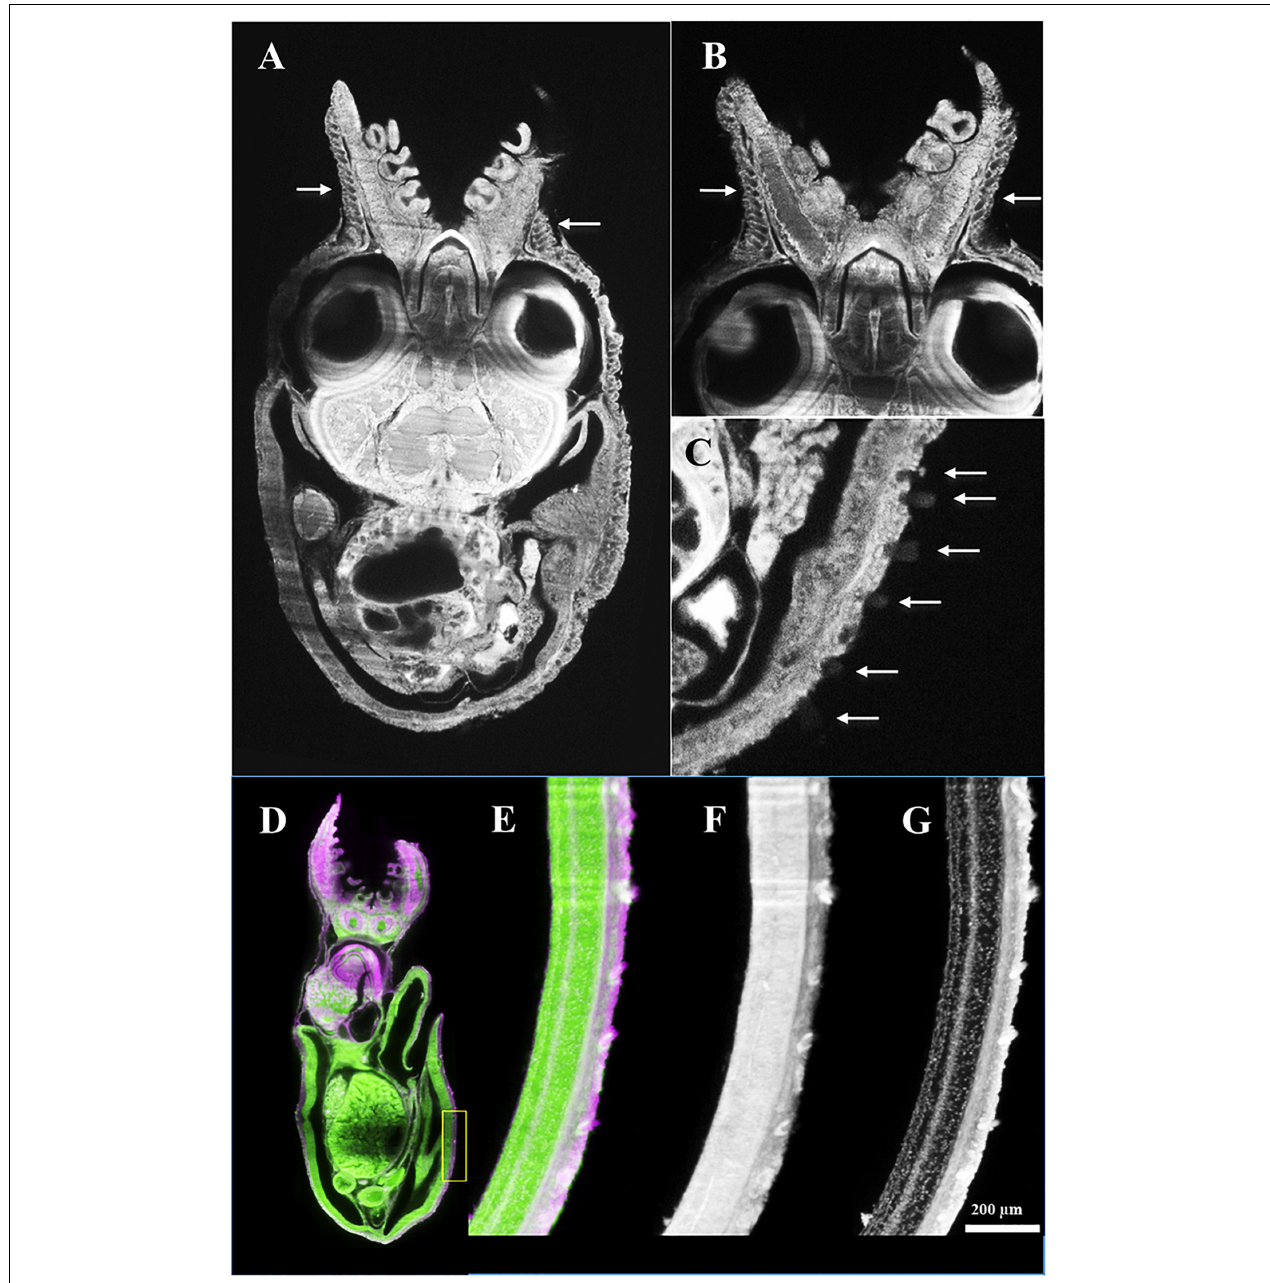
FIGURE 7 | Octopus vulgaris SPIM images. (A–C) age 0 day, ML 1.6 mm, horizontal section, autofluorescence image excited at 638 nm; and (D–G) 30 days, ML 3.8 mm, sagittal section, labeled with Evans blue and excited at 638 nm (pink color) and autofluorescence excited at 488 nm (green color). Note high density of Kölliker’s organs (KO) (white arrows) on skin of aboral arm (A,B) in comparison with mantle surface (C) . (D) Whole animal and detail of the ventral mantle (inside yellow rectangle) showing KO under different excitation conditions: (E) autofluorescence + Evans blue, (F) autofluorescence, and (G) Evans